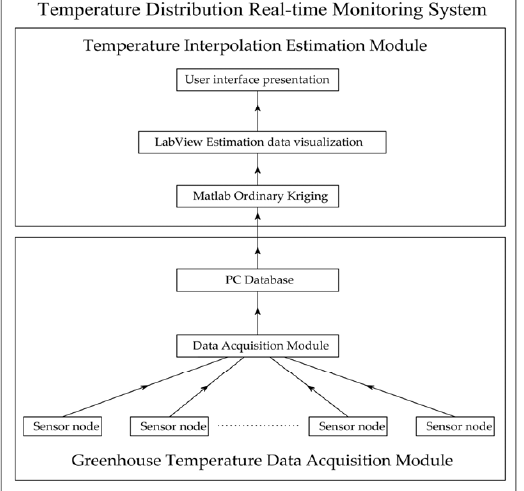
Figure 3. Greenhouse Temperature Distribution Real-time Monitoring System (TDRMS) flow dia- gram.